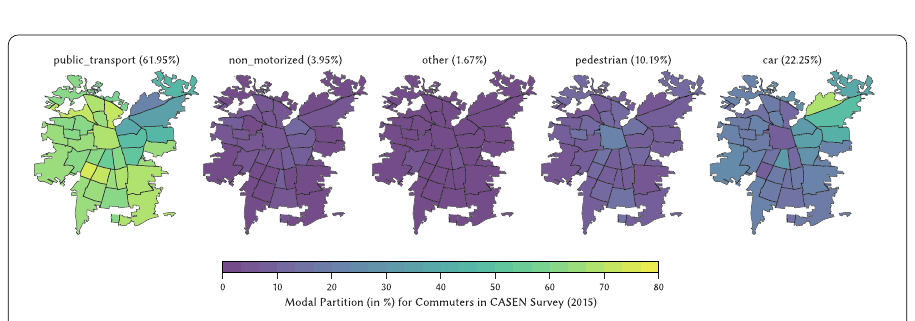
Figure 4 Spatial distribution of mode of transportation usage ( modalpartition ) per home municipality in Santiago, according to the CASEN survey. The maps show how public transport and car usage reflect the socio-economic segregation of the